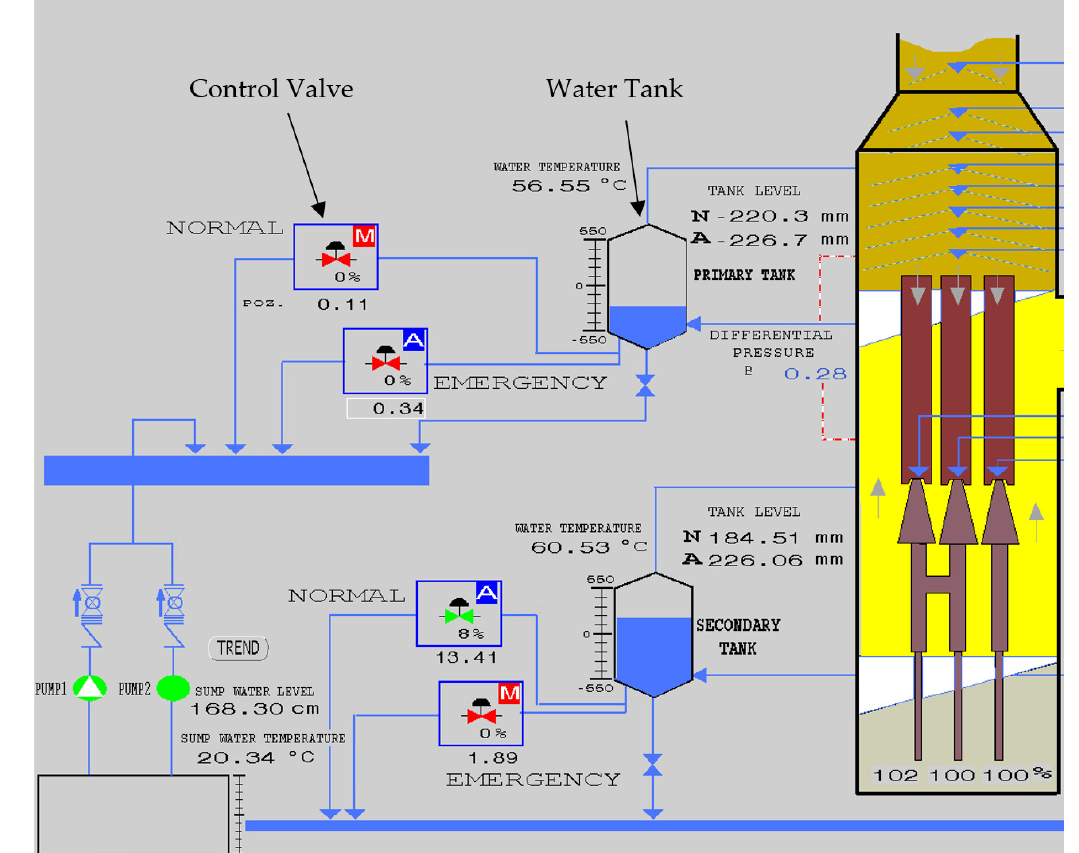
Figure 2. Blast furnace gas cleaning tank system and level